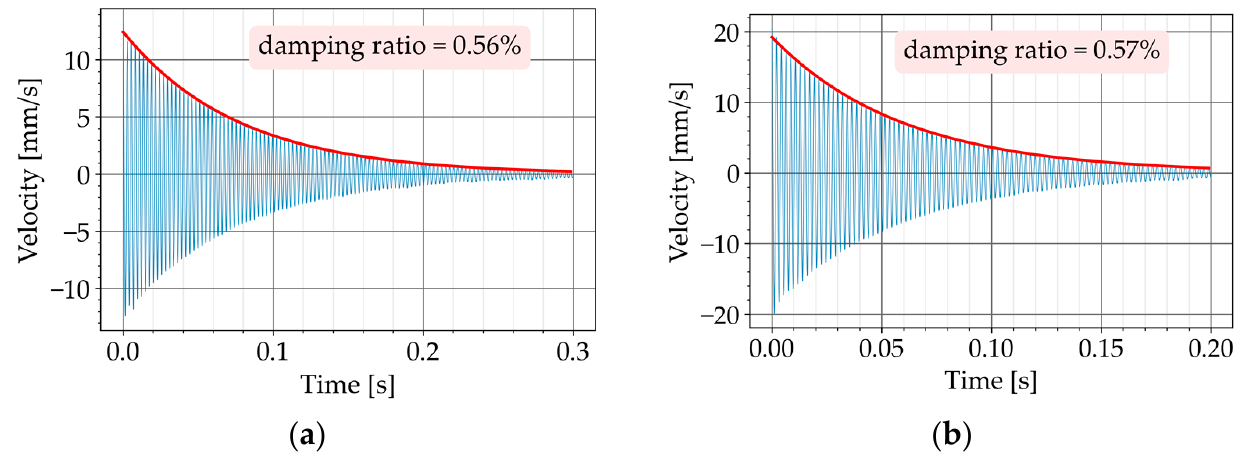
Figure 12. Decaying free vibration of the beams with the dampers (second step of the free vibration test). ( a ) P670: free vibration with damper 2 × K2. ( b ) P600: free vibration with damper 2 × K3.